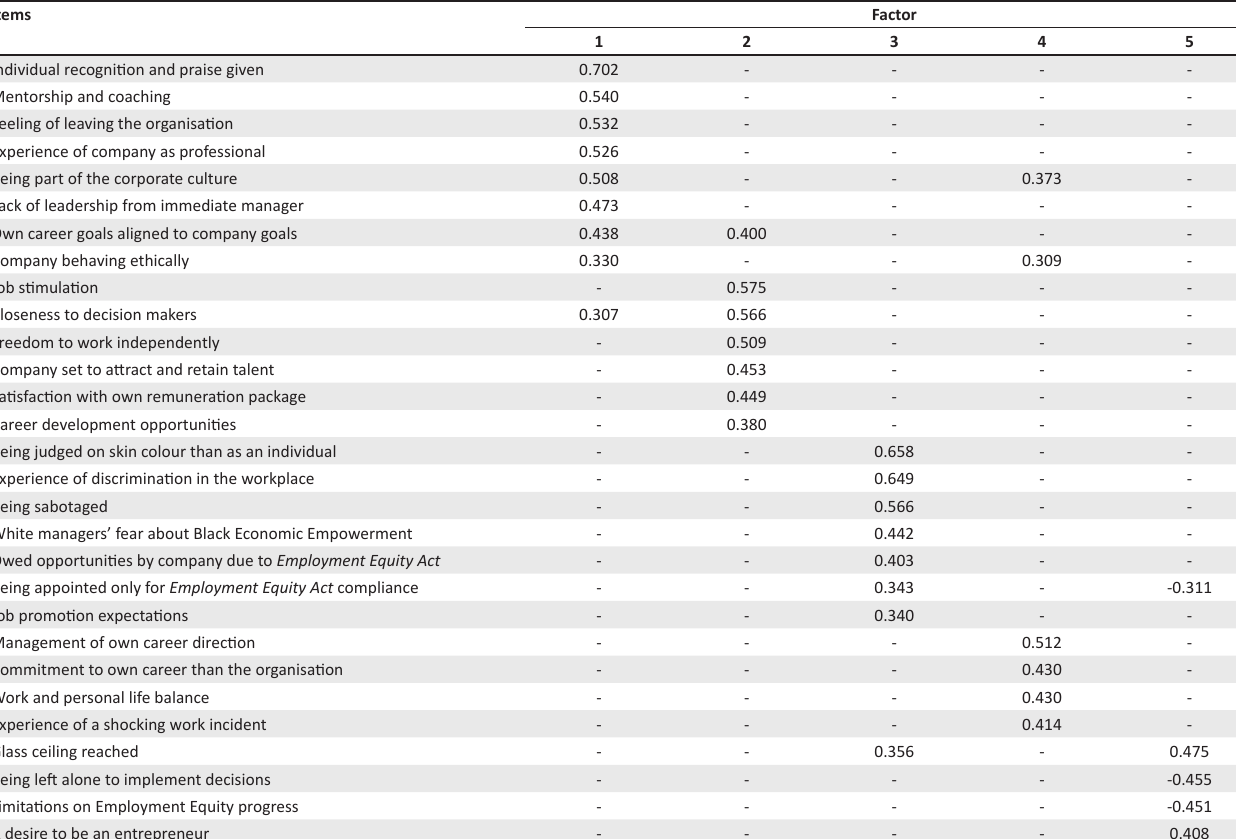
TABLE 12: First-order factor analysis: Factor matrix.